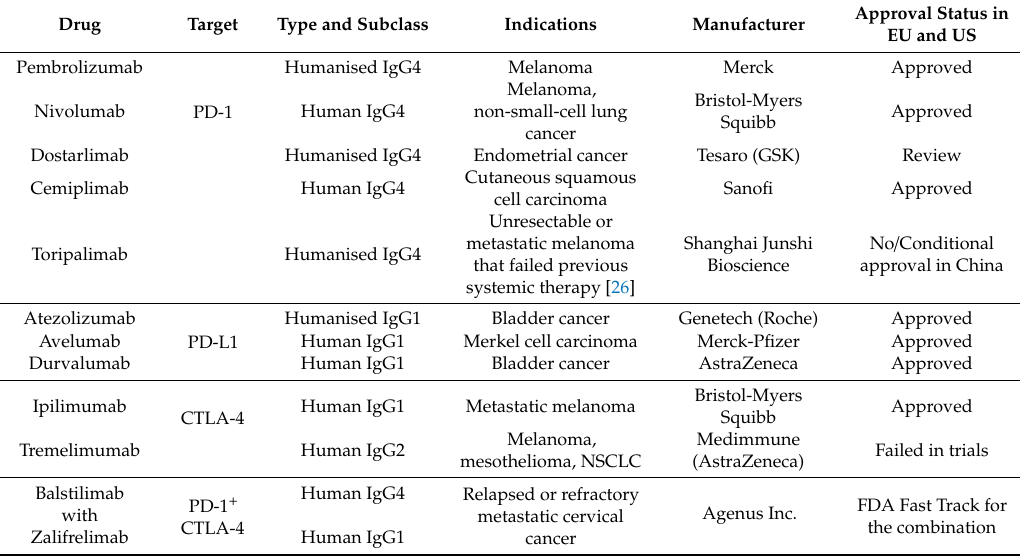
Table 1. Therapeutic mAbs targeting human